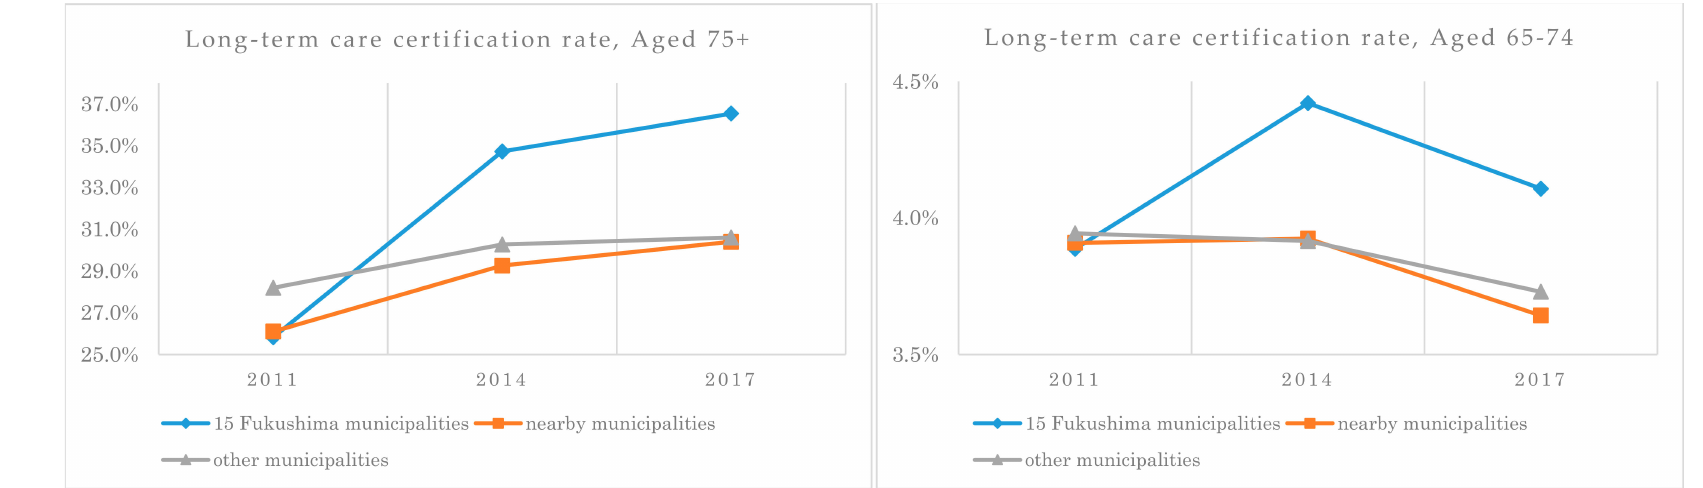
Figure 2. The change of long-term care certification rate for 6 years by age